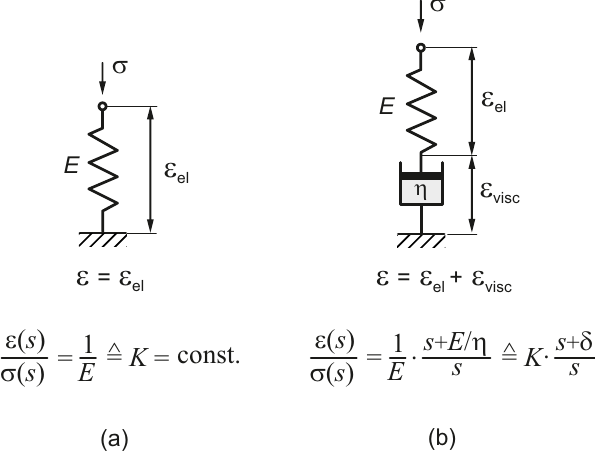
Figure 8. Mechanical analog and resulting transfer function of a sensor with (a) ideal linear time-independent sensitivity K (no drift) and (b) time-dependent sensitivity change due to viscoelastic mate- rial properties (drift); σ mechanical stress, (cid:15) mechanical strain, E Young’s modulus of the elastic spring, η viscosity of the dashpot.